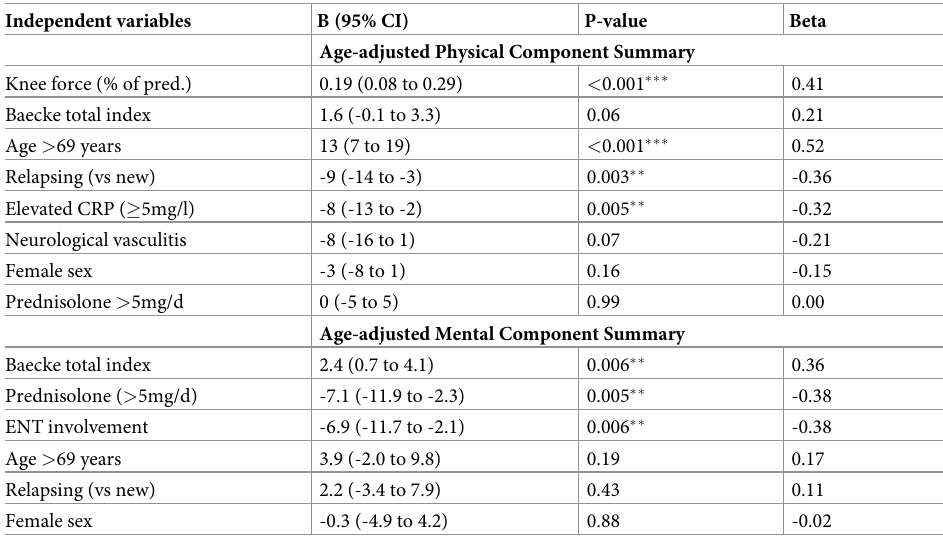
Table 3. Multivariable linear regression for quality of life in ANCA-associated vasculiits.